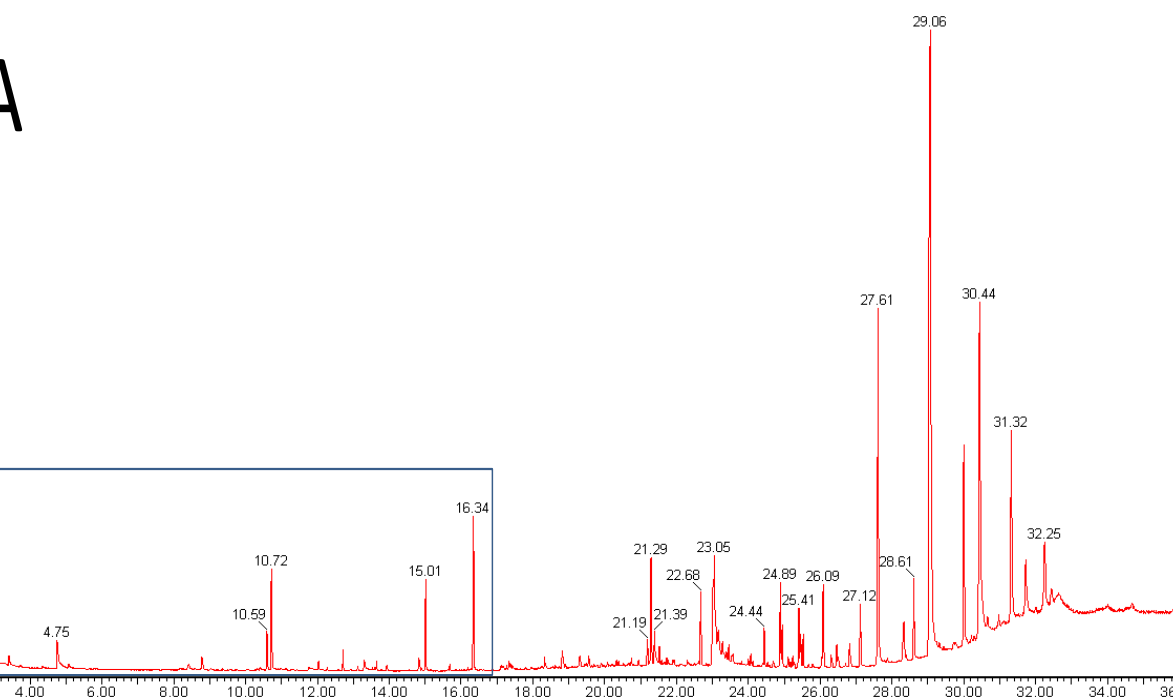
Figure 2. GC-MS (TIC) chromatograms of apple fruit volatiles showing the dependency of